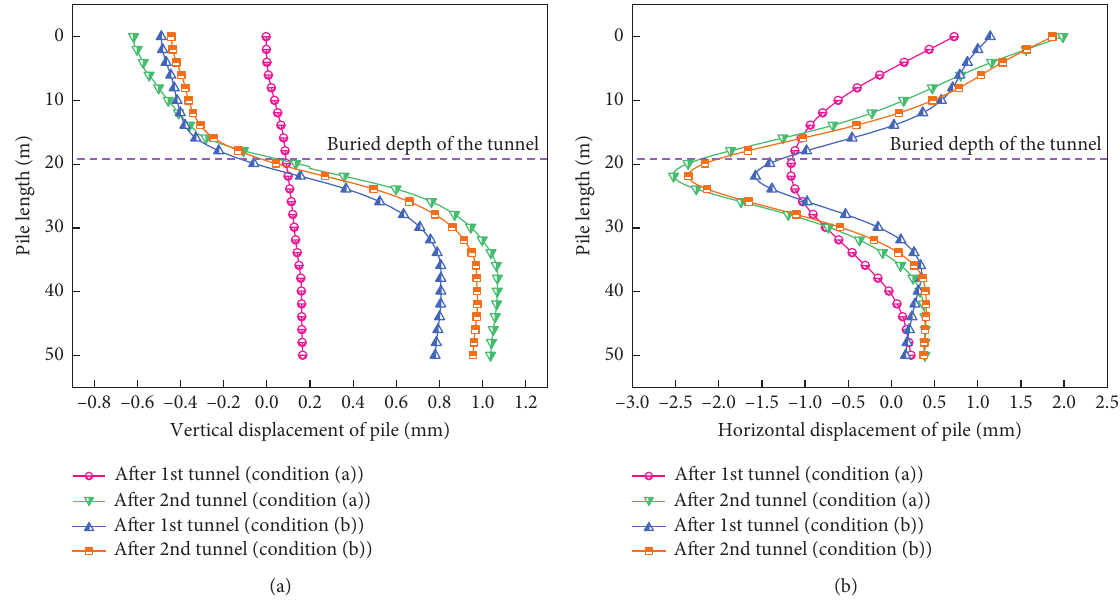
Figure 16: Displacement of pile foundation. (a) Vertical displacement. (b) Horizontal